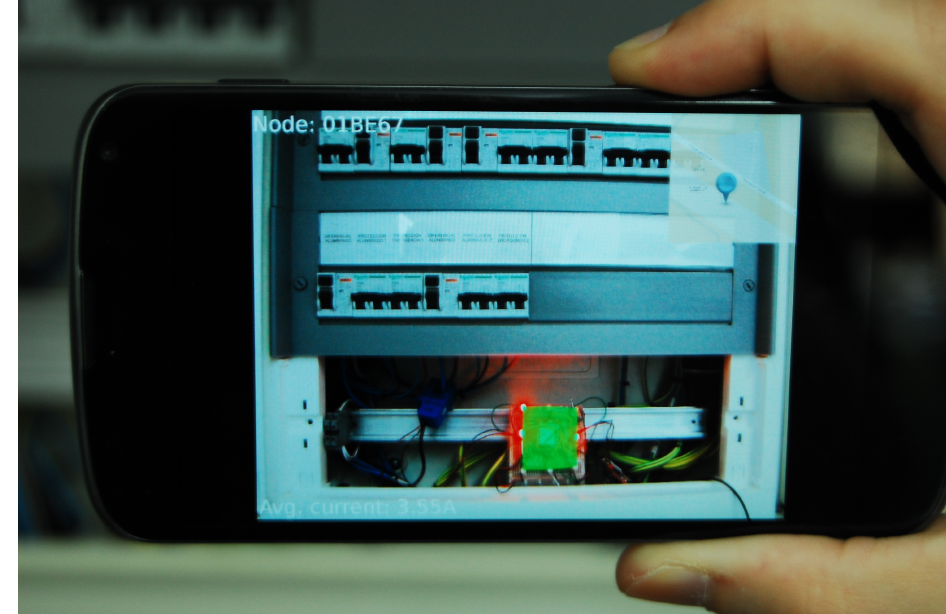
Figure 15. AR application in the testbed deployment showing the status of an electrical